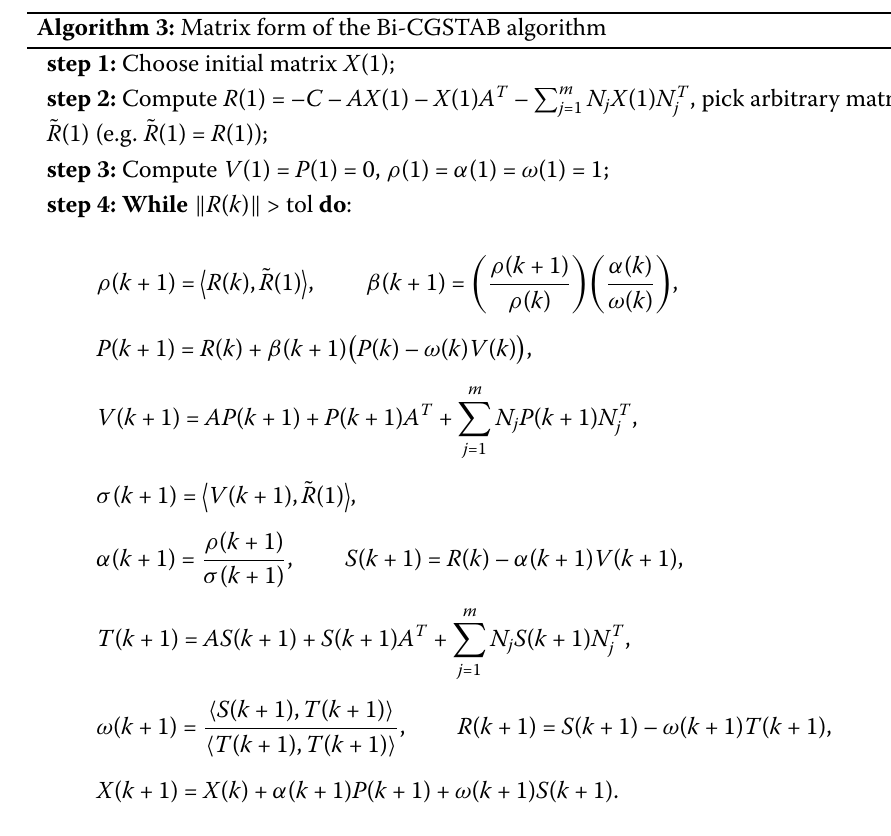
Algorithm 3: Matrix form of the Bi-CGSTAB algorithm